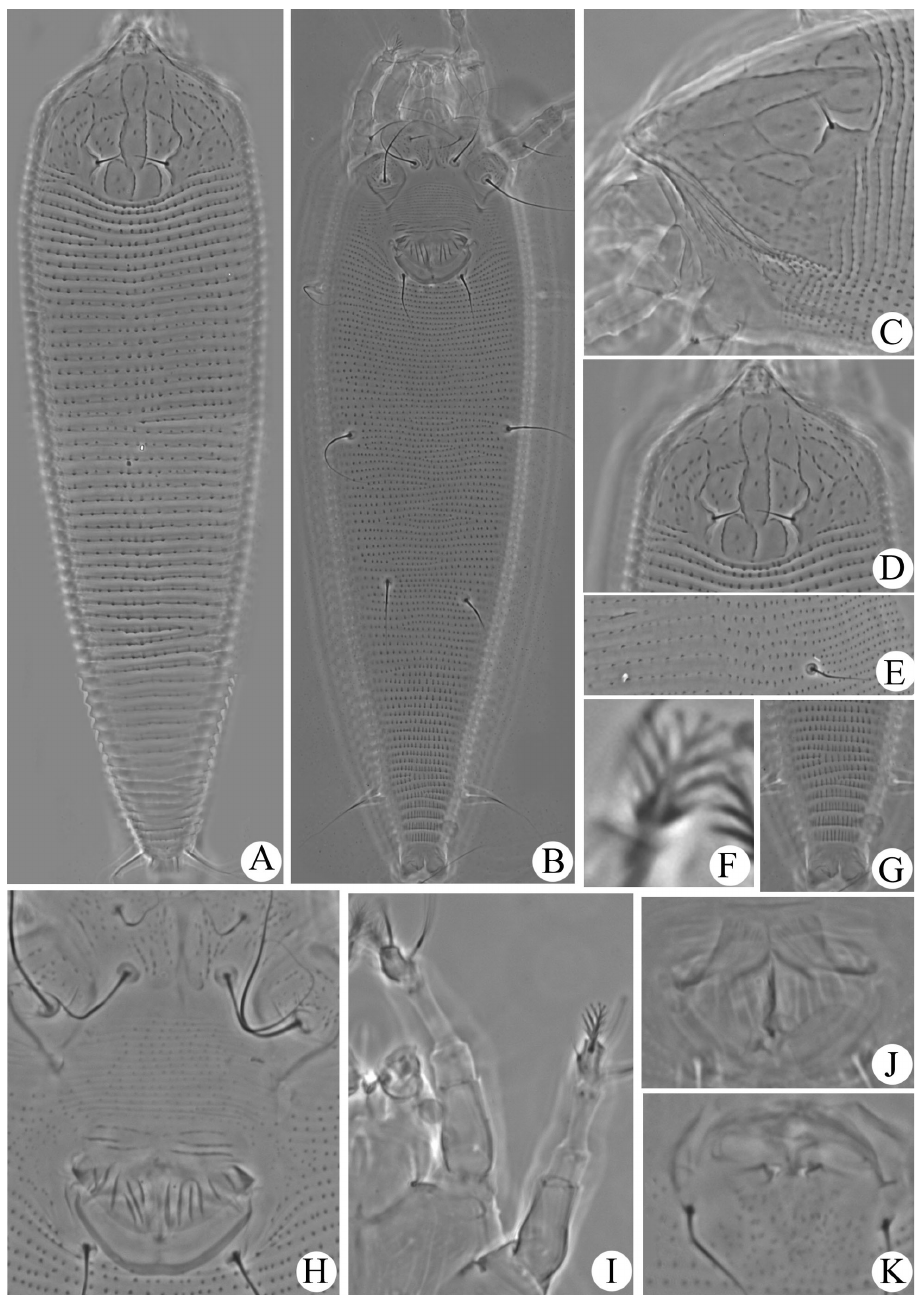
Figure 5. Micrographs of Phyllocoptes terniflores sp. n.: A dorsal view of female B ventral view of female C lateral view of anterior body region D prodorsal shield E lateral view annuli F empodium G ventral view of posterior opisthosoma H coxigenital region and female genitalia I leg I and leg II J female internal genitalia K male genital